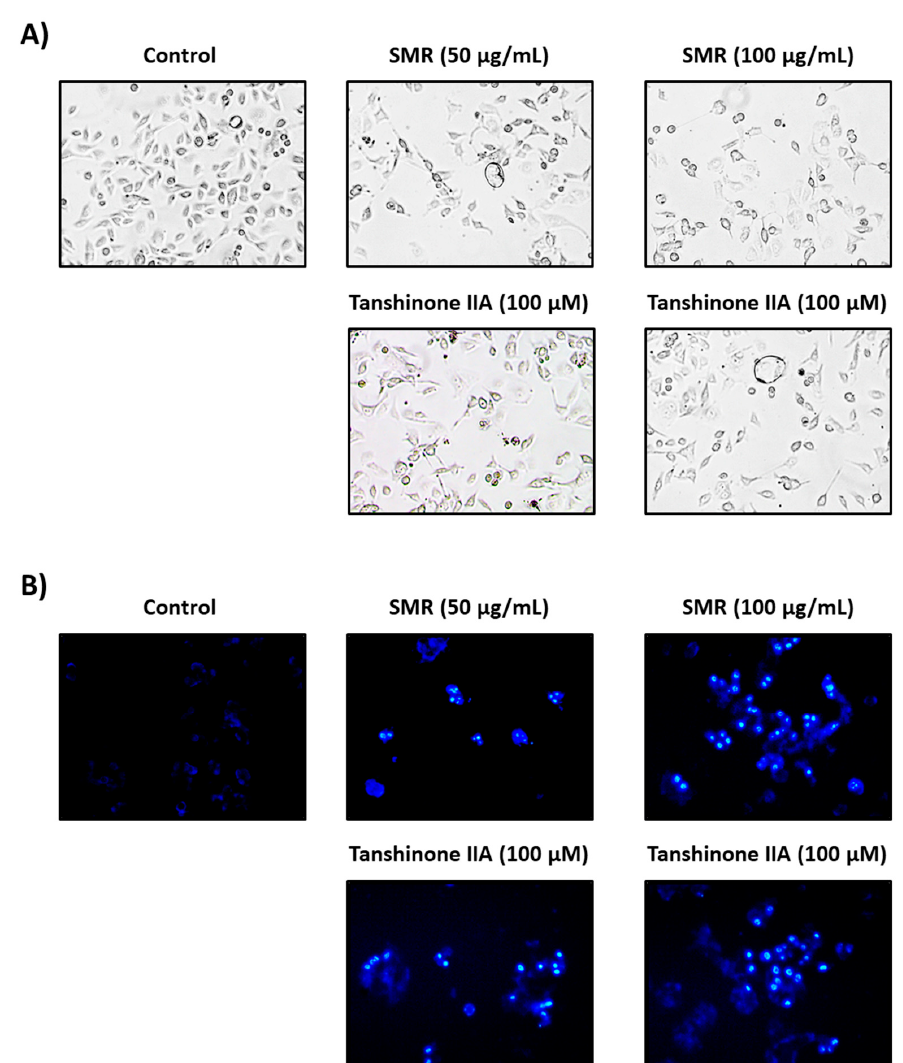
Figure 3. Effects of 70% ethanol extract of Salviae Miltiorrhizae Radix (SMR) and tanshinone IIA on Figure 3. E ff ects of 70% ethanol extract of Salviae miltiorrhizae Radix (SMR) and tanshinone IIA on apoptosis in HCT ‐ 116 cells. ( A ) Morphology changes in HCT ‐ 116 cells. ( B ) Fluorescence microscopic apoptosis in HCT-116 cells. ( A ) Morphology changes in HCT-116 cells. ( B ) Fluorescence microscopic images of apoptotic HCT ‐ 116 cells stained with Hoechst 33342. images of apoptotic HCT-116 cells stained with Hoechst